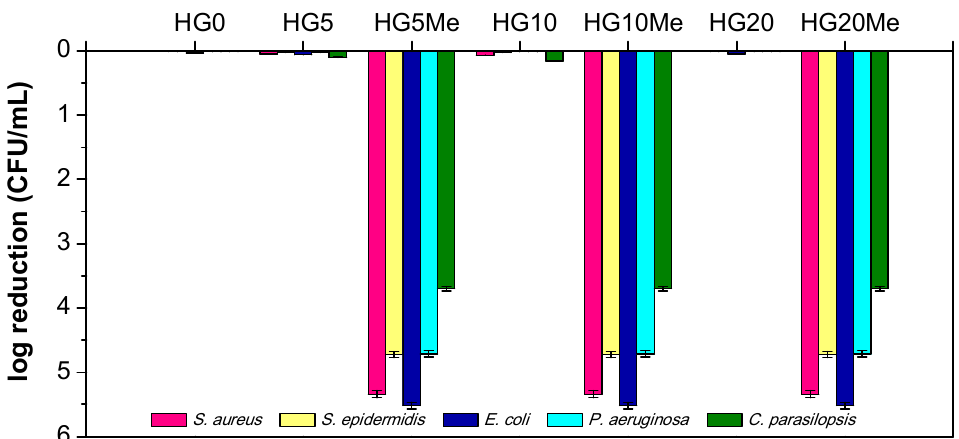
Figure 6. The antimicrobial ability of unmodified and methylated hydrogels against different microorganisms.